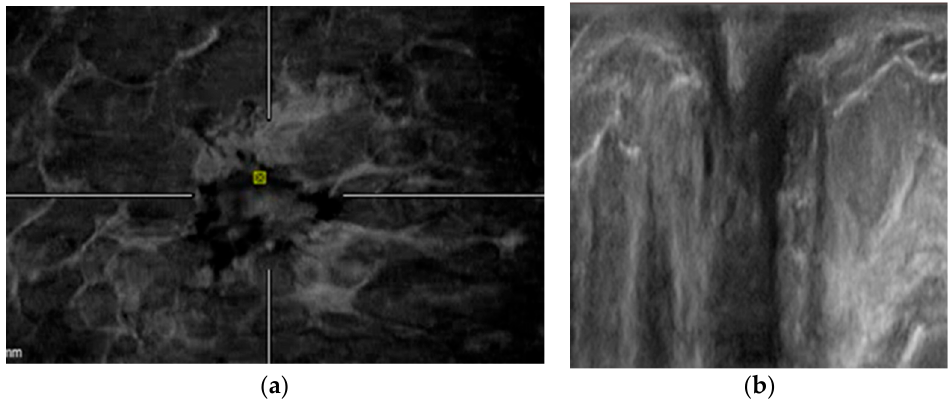
Figure 4. 63-year-old woman with a main nodule (invasive ductal carcinoma biopsy-proven). Other smaller lesions (with a size from 5 to 8 mm) are seen in ABVS and not visualized on conventional HHUS.